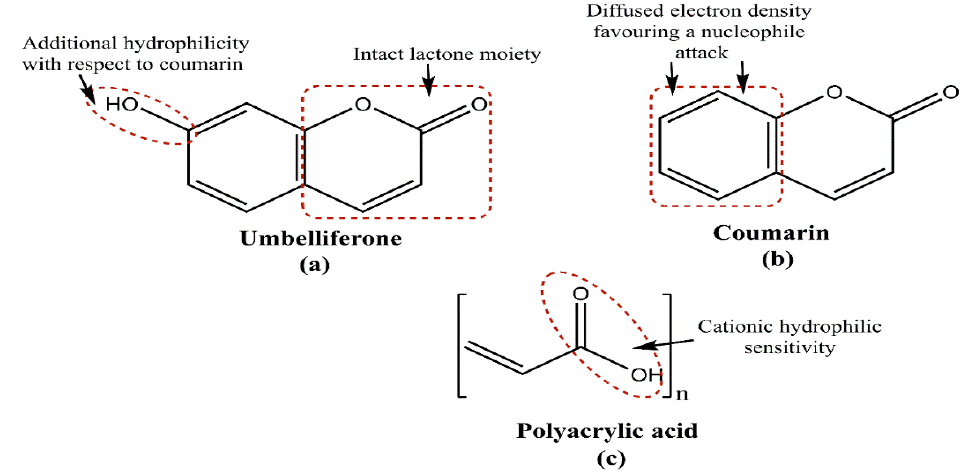
Figure 13. Chemical structures of ( a ) umbelliferone, ( b ) coumarin and ( c ) polyacrylic acid, depicting their philic – phobic sensitivities for an interaction likelihood.